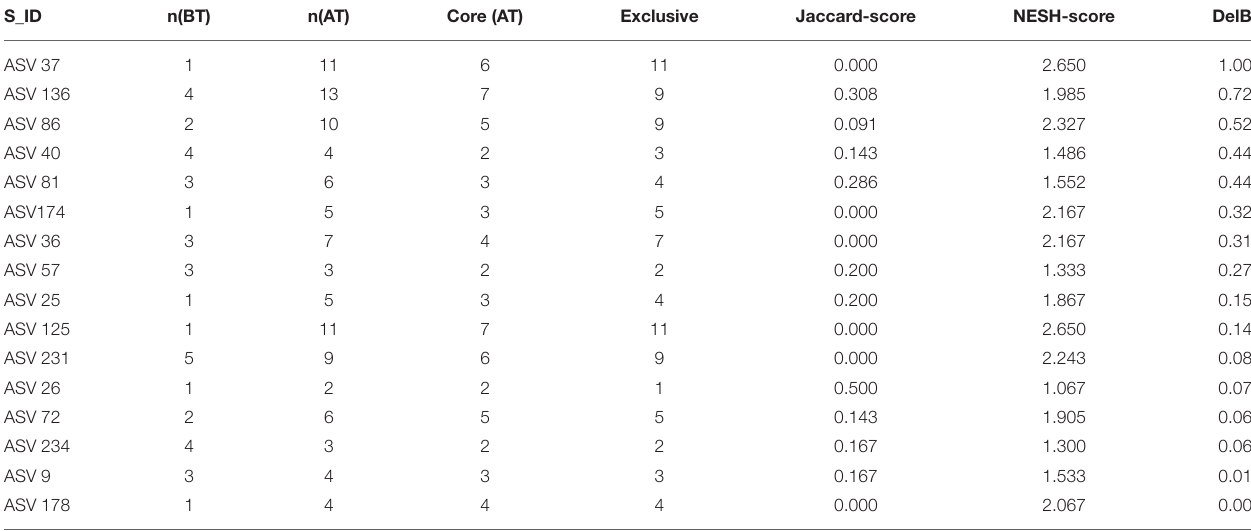
TABLE 2 | Properties of network nodes in BT group and AT